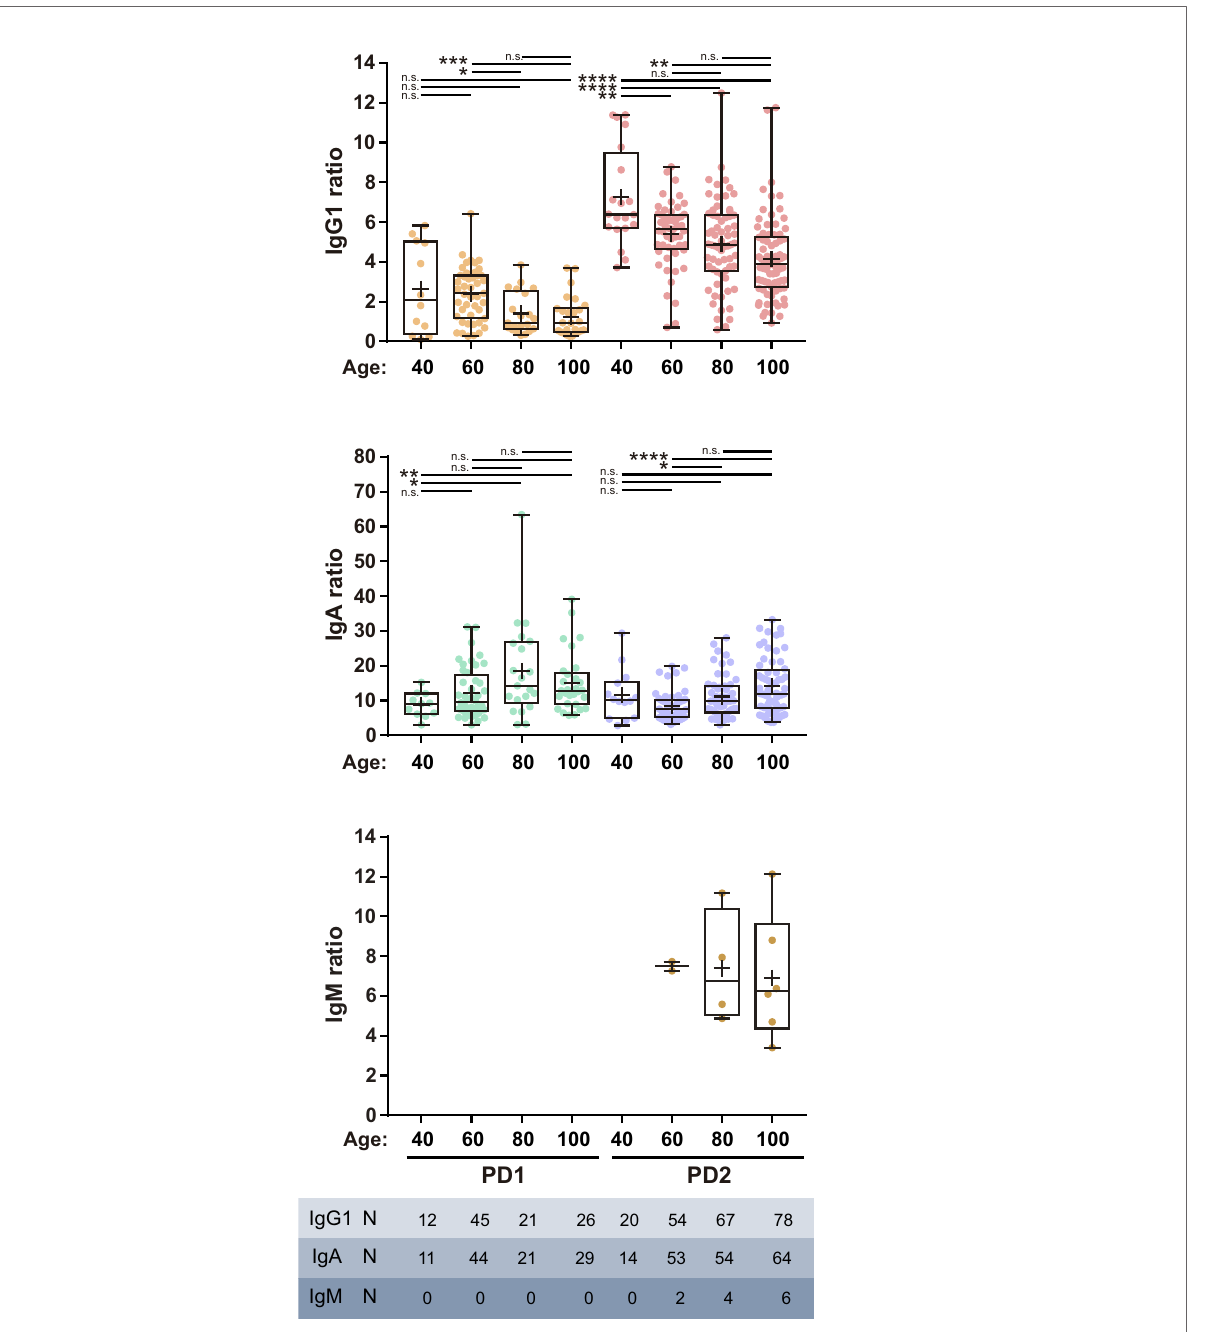
FIGURE 4 | Effect of the age of the donor in the humoral response. IgG1, IgA and IgM titers of seropositive samples collected after the fi rst (PD1) or the second (PD2) dose of BNT vaccine. Samples were grouped by the age of the donor as 40, ≤ 40; 60, 41-60; 80, 61-80; 100, 81-100 year-old. Median, line inside boxes; mean, +; bars, min and max values. Independent one-way ANOVA was used to compare PD1 and PD2 data series (IgG1 PD1, p = 0.0091; IgG1, PD2, p < 0.0001; IgA PD1, p = 0.0182; IgA PD2, p = 0.0002). IgG1 PD1, IgA PD1, IgA PD2 groups, Brown-Forsythe ANOVA and multiple comparisons with Games-Howell ’ s correction. IgG1 PD2, one-way ANOVA with Sidak ’ s correction. n.s., no signi fi cance; *p <0.05; **p ≤ 0.01; ***p ≤ 0.001; ****p <